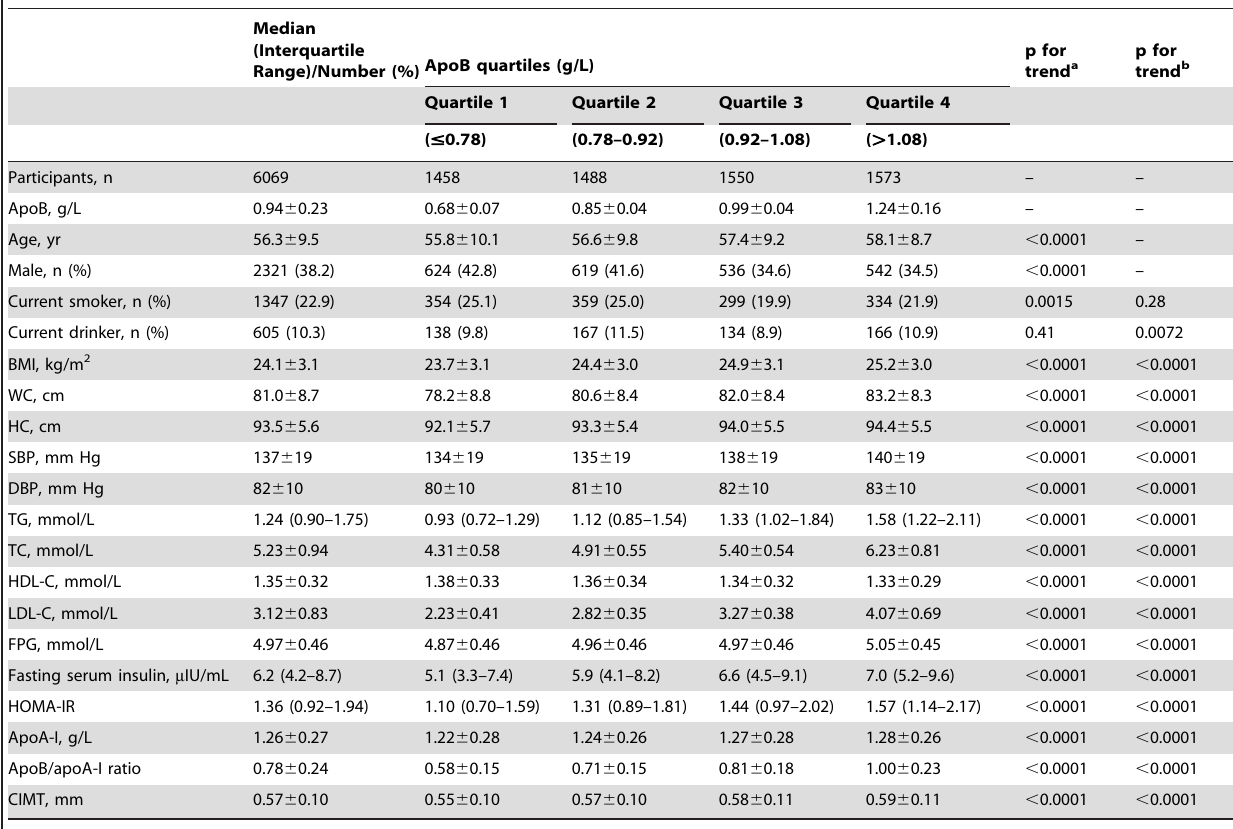
Table 1. Characteristics of study